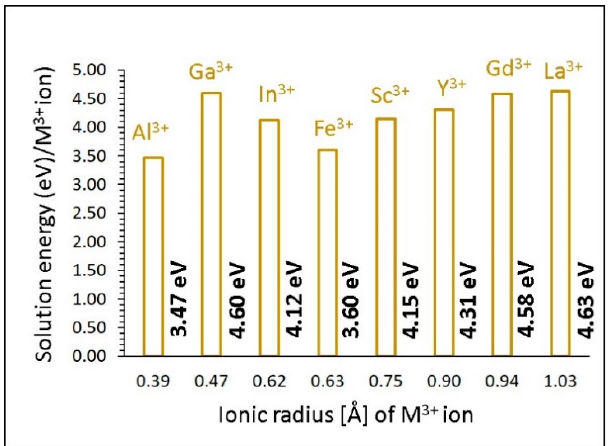
Figure 6. Solution energy of M 2 O 3 (M = Co, Mn, Ni, Mg, Zn, Sr and Ba) with respect to the M 3+ ionic radius.